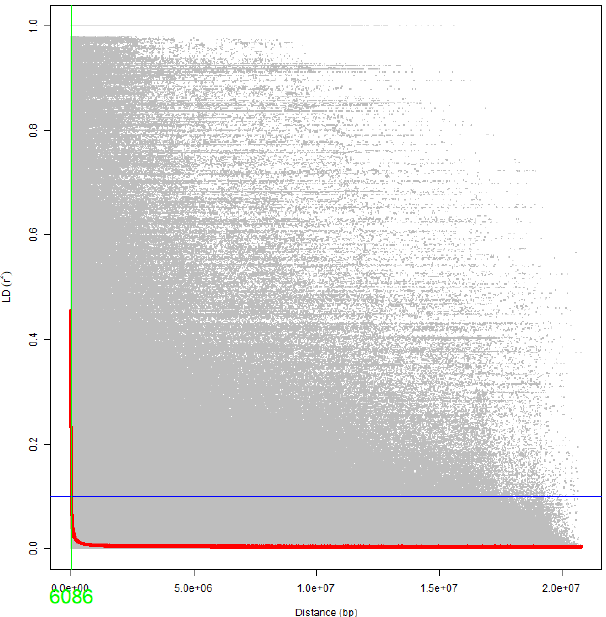
Figure 4. Distribution of the marker density and decay of the linkage disequilibrium (LD) over distance presented as an accumulative distribution. The x-axis indicates the distance (kb) between SNPs, the y-axis indicates the LD ( r 2 ), and the solid blue horizontal line indicates the distance of the LD pattern for all genotypes in wild soybean.